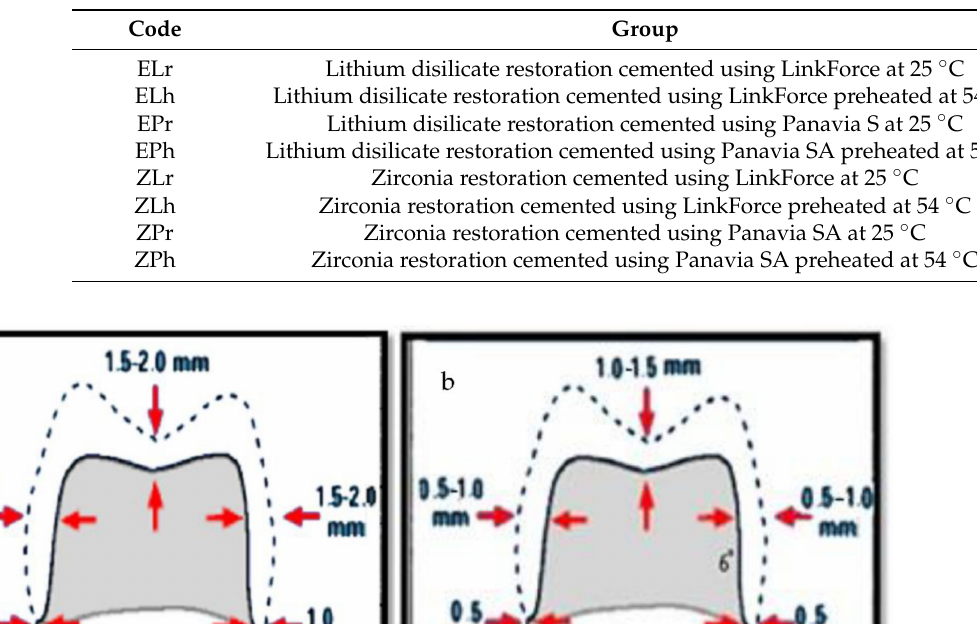
Figure 1. The root was covered with a thin layer of wax using the wax dipping technique. An amount of 80 selected teeth were divided into 8 groups ( n = 10) according to the restoration material type (zirconia or lithium disilicate), the cement type (Panavia SA cement plus or G-Cem LinkForce cement), and the preheating temperature at 54 ◦ C or at 25 ◦ C as shown in Table 1. For teeth preparation, the CAD/CAM system was used to standardize the preparation [32]. Standardization started with 2 teeth which were prepared using a hand piece attached to a dental surveyor (Dentalfarm A3006 B, Turin, Italy). For lithium disilicate, the preparation was 1 mm chamfer finish line, 2 mm functional cusp reduction, and 1.5 mm non-functional cusp reduction. For zirconia, the preparation was 0.5 mm chamfer, 1.5 mm functional cusp reduction, and 1 mm for non-functional cusp reduction as shown in Figure 2. The preparation was checked using a pre-preparation putty index (Imflex Putty, Meta Biomed Co., Chungcheongnam-do, Korea). Table 1. The study groups.